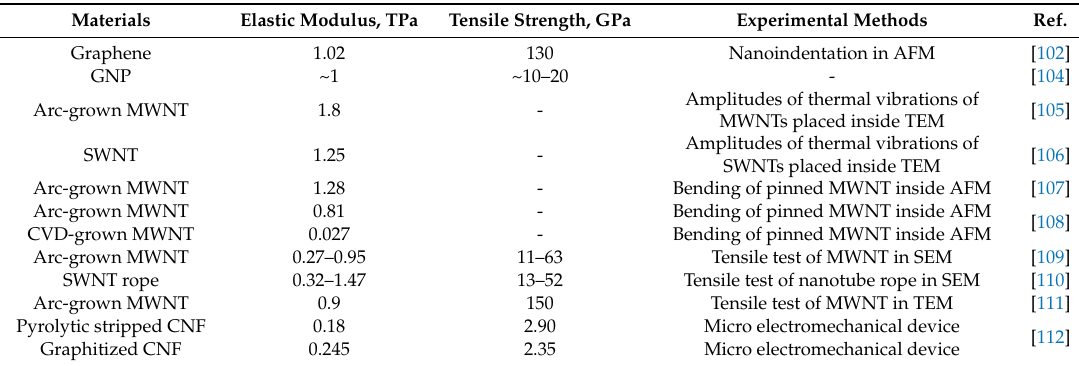
Table 4. Experimental mechanical features of carbonaceous